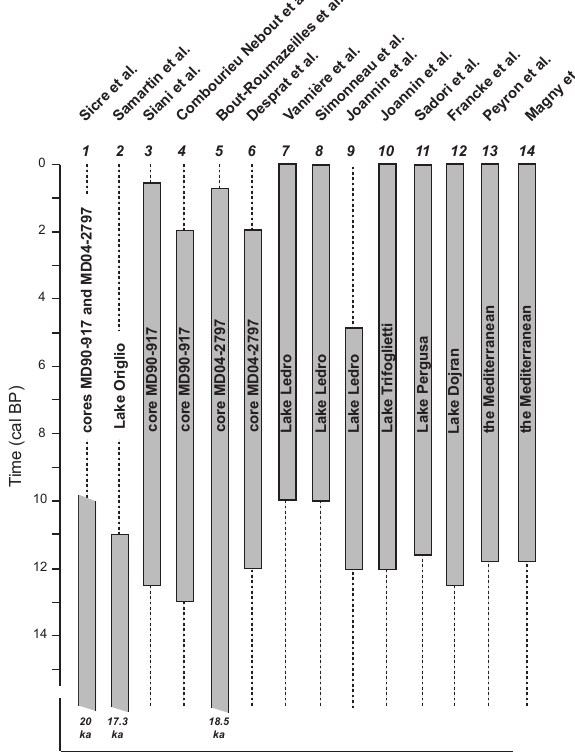
Fig. 2. Time windows documented by the fourteen contributions in this special